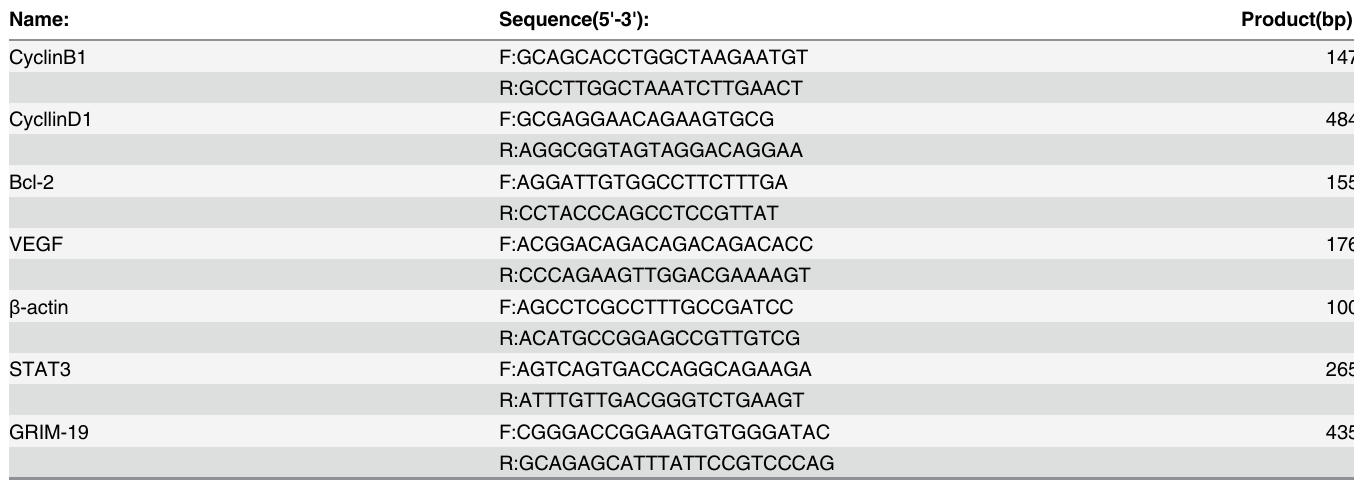
Table 1. Primer sequences for each targeted